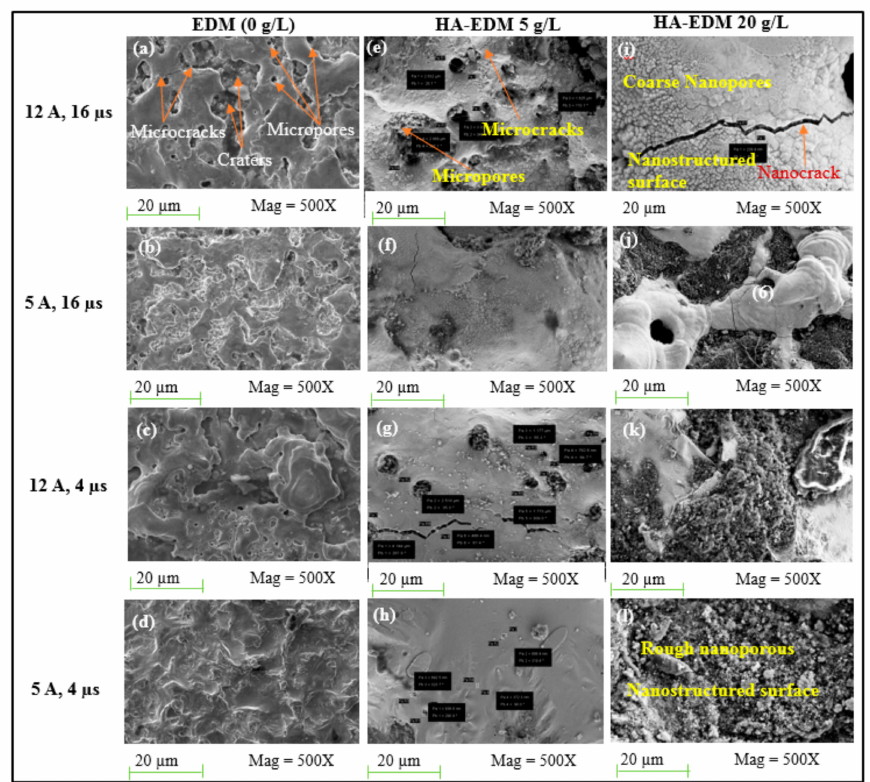
Figure 9. Influence of current and HA powder concentration on the modified surface morphology ( a – l ) showing microcracks, micropores, shallow craters, and nanostructure formation (reproduced with permission from ref.